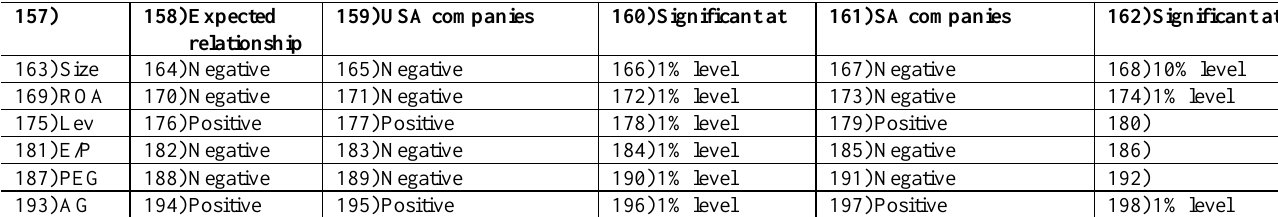
Table 11: Comparison – other variables: Five-year growth